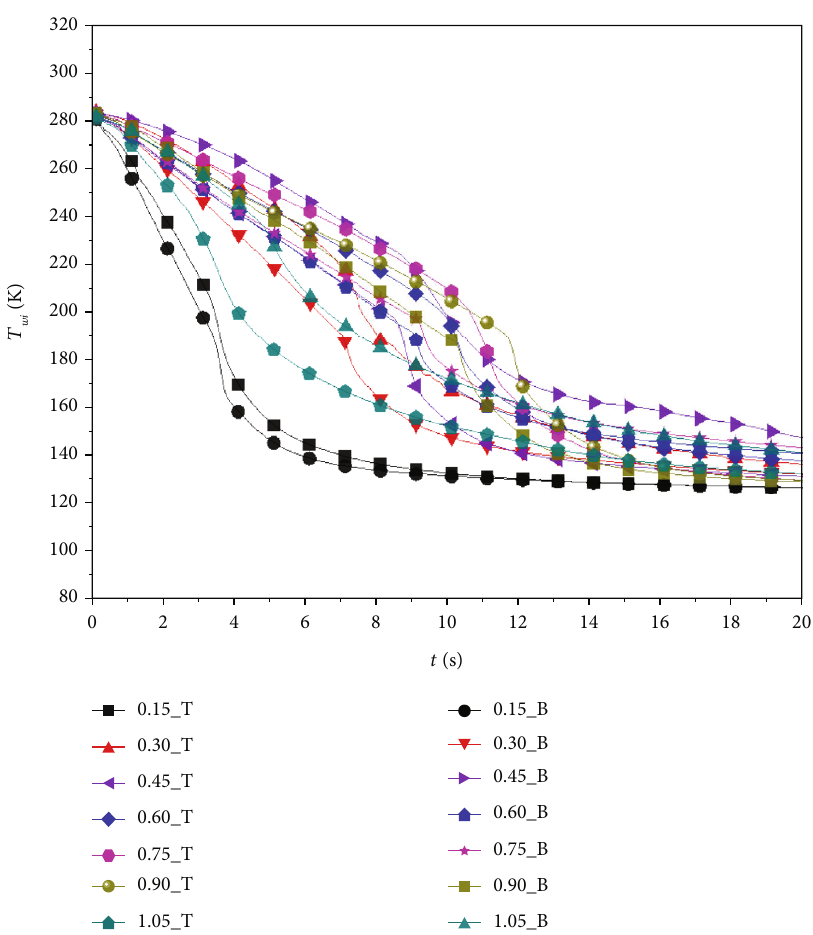
Figure 5: Data curves for Exp. 4 ( _ m = 0 : 562 kg/s , p